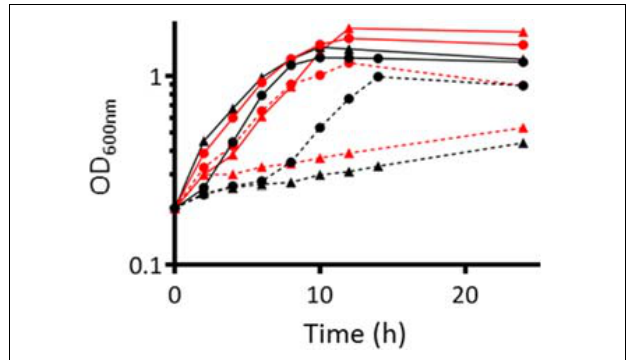
FIGURE 4 | Growth of WT and nirBD narB S. meliloti strains. WT ( • ) or nirBD narB ( (cid:78) ) strain were grown to exponential phase (OD 600 = 0.2–0.3) in Vincent Minimal Medium (VMM) containing either glutamate (red lines) or NH 4 Cl (black lines) as the sole nitrogen source. At time zero, cells grown in VMM with glutamate or NH 4 Cl were collected, centrifuged, washed once by centrifugation, and resuspended at the same OD 600 in VMM containing only KNO 3 (dotted line), or a combination of KNO 3 and glutamate (red solid line) or NH 4 Cl (black solid line). OD 600 was measured over a 24 h period. A representative experiment is shown on the figure.